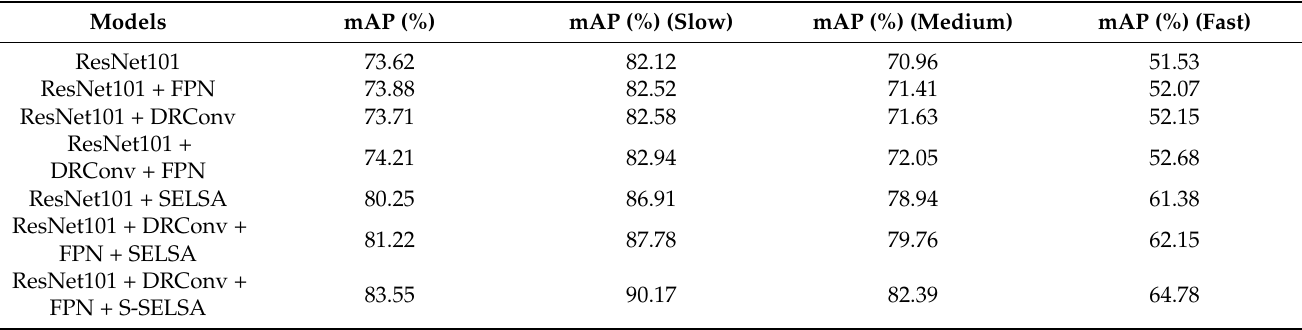
Table 2. The experiment results on the Image VID